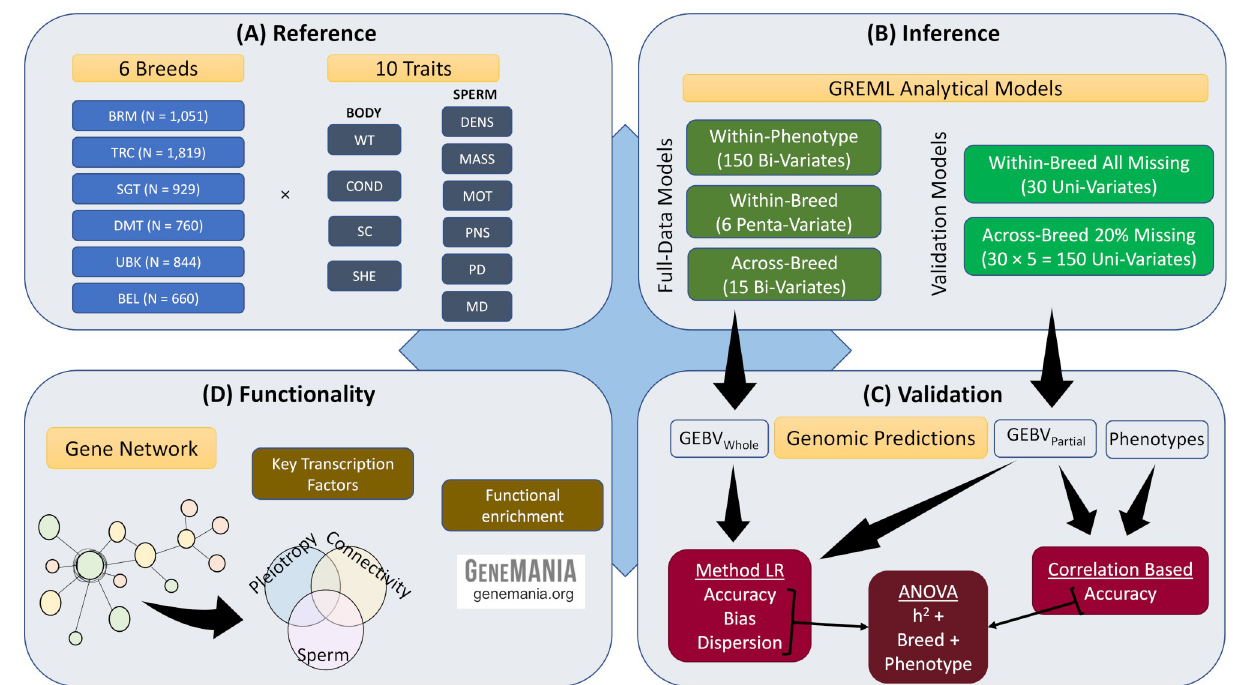
Fig 1. Overview of the analysis. The assembled multi-breed reference population (A) comprised 6,063 bulls from six tropically adapted breeds (BRM = Brahman; TRC = Tropical Composite; SGT = Santa Gertrudis; DMT = Droughtmaster; UBK = Ultra Black; and BTC = Belmont Tropical Composite) with measures on 10 fertility-related quantitative phenotypes including four measured on the bull’s body (WT = body weight; COND = condition score; SC = scrotal circumference; and SHEATH = sheath score) and six measured on the bull’s semen (DENS = density; MASS = mass; MOT = motility; PNS = percent normal sperm; PD = proximal droplets; and MD = midpiece deformities). Together with the high- density SNP genotypes, the inference step (B) used multi-variate and multi-breed GREML analytical models which can be split into two categories: Full- Data Models with all phenotypic records and used to generate GEBV Whole genomic predictions, and Cross-Validation Models where phenotypes from individuals in the validation group were set as missing values and used to generate GEBV Partial genomic predictions. For the validation step (C) , GEBV Whole and GEBV Partial were combined using Method LR approaches to compute accuracy, bias, and dispersion, while GEBV Partial and the adjusted phenotypes were combined to compute correlation-based accuracy. Measures of accuracy, bias and dispersion were subjected to an ANOVA model that contained the effects of heritability (h 2 ), breed and phenotype. The final step (D) aimed at identifying functional variants. SNP effects were estimated and, when anchored to individual genes, subjected to the Association Weight Matrix to infer a network that exploited the triple concept of degree connectivity, pleiotropy, and sperm expression to identify key transcription factors harbouring causal